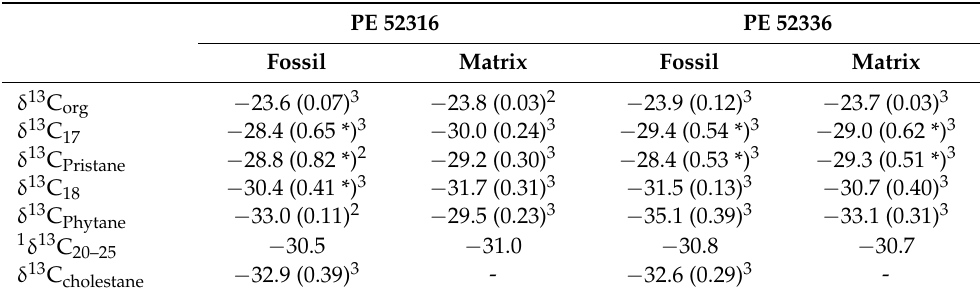
Table 4. Average δ 13 C values (bulk residue and compound specific) for PE 52316 and PE 52336, given in per mil